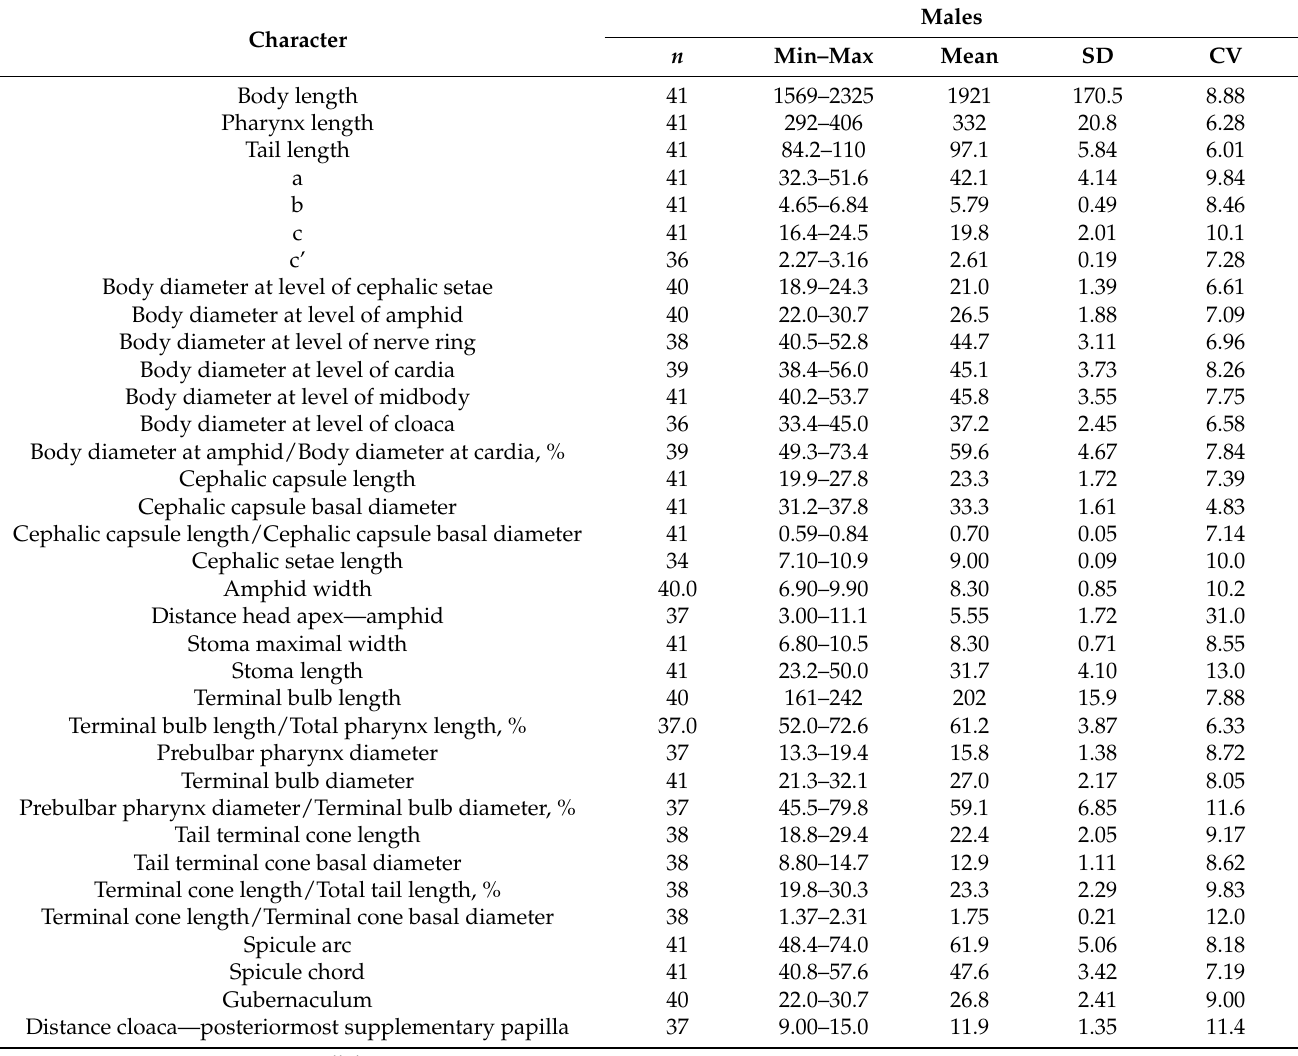
Table 4. Morphometrics of males Acanthopharynx micans from samples PA13 and PA21